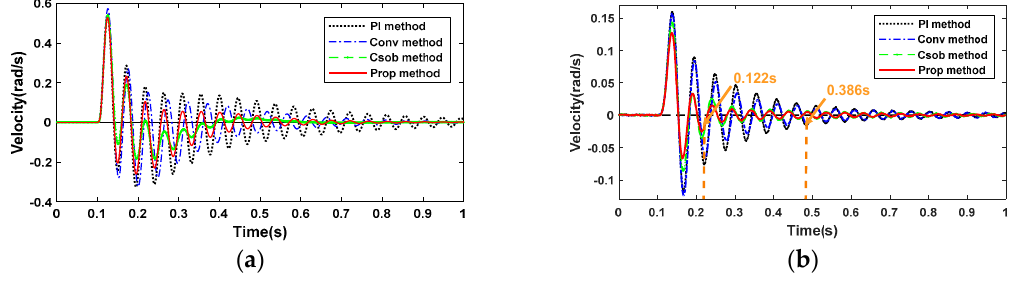
Figure 15. Input disturbance suppression with link-side controller: ( a ) simulations; ( b ) experiments.